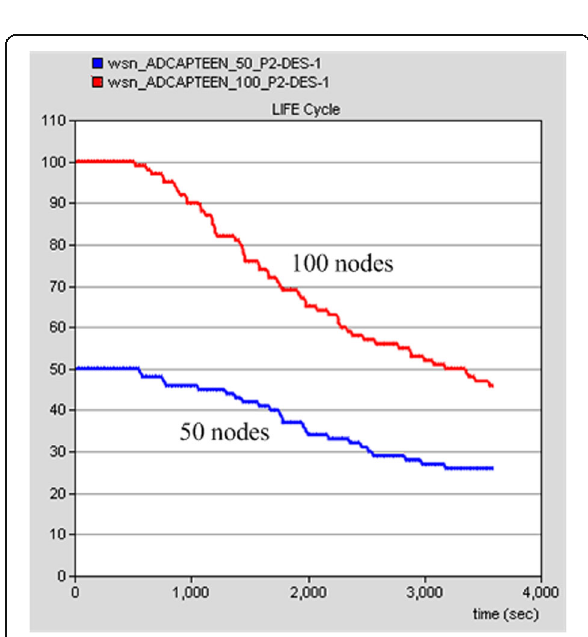
Fig. 11 The life cycle comparison of ADCAPTEEN in different scales. This figure shows the network life cycle of ADCAPTEEN compared 100 nodes with the 50-node network topology. We can see that established ADCAPTEEN network topology is also effective. Compared with Fig. 9, ADCAPTEEN protocol results in a greater network life cycle than the APTEEN protocol under two network topologies. ADCAPTEEN outperforms APTEEN in terms of scalability. It is suitable for large-scale